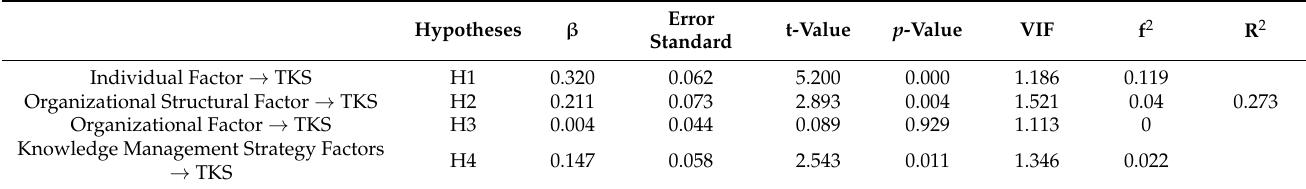
Table 5. Verification of